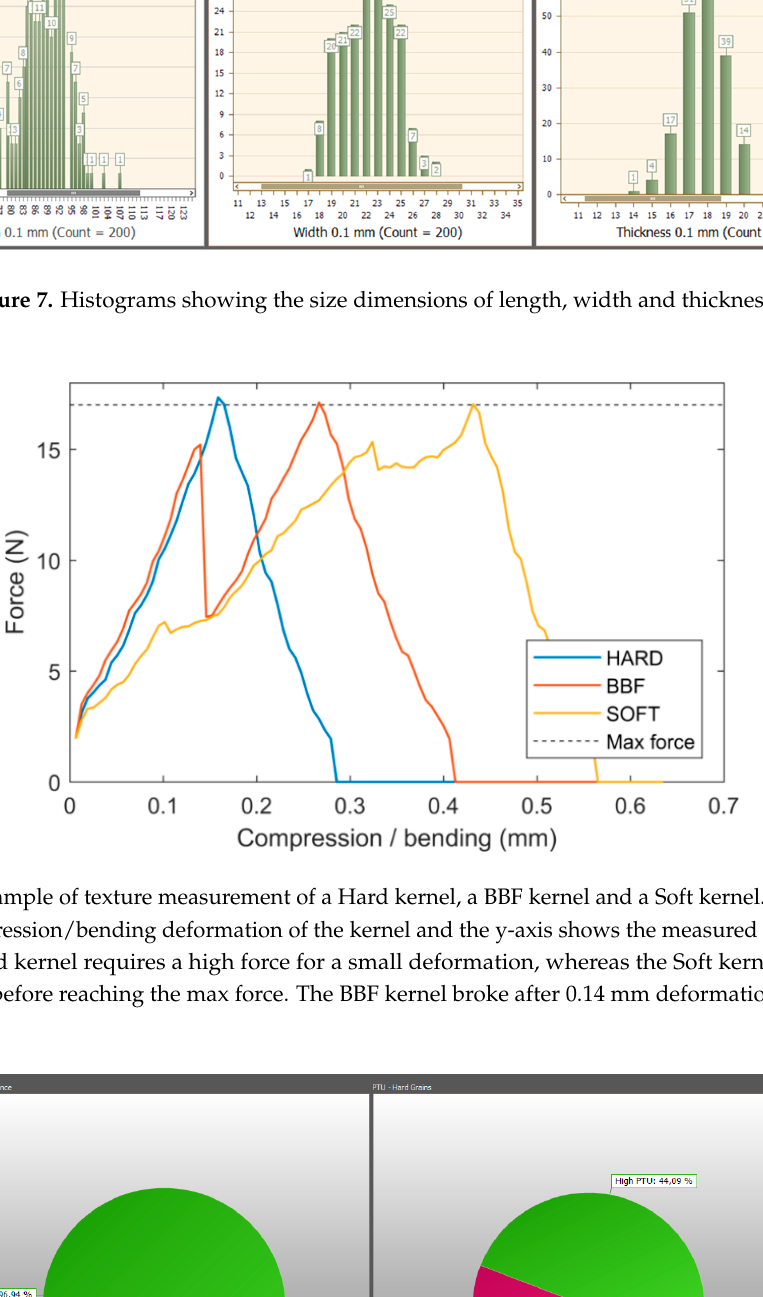
Figure 9 . ( a ) Crack resistance parameters of Hard (green), broken (BBF) (pink) and Soft (orange) kernels; and ( b ) PTU in hard kernels, which can be High PTU (green) or Low PTU (pink).